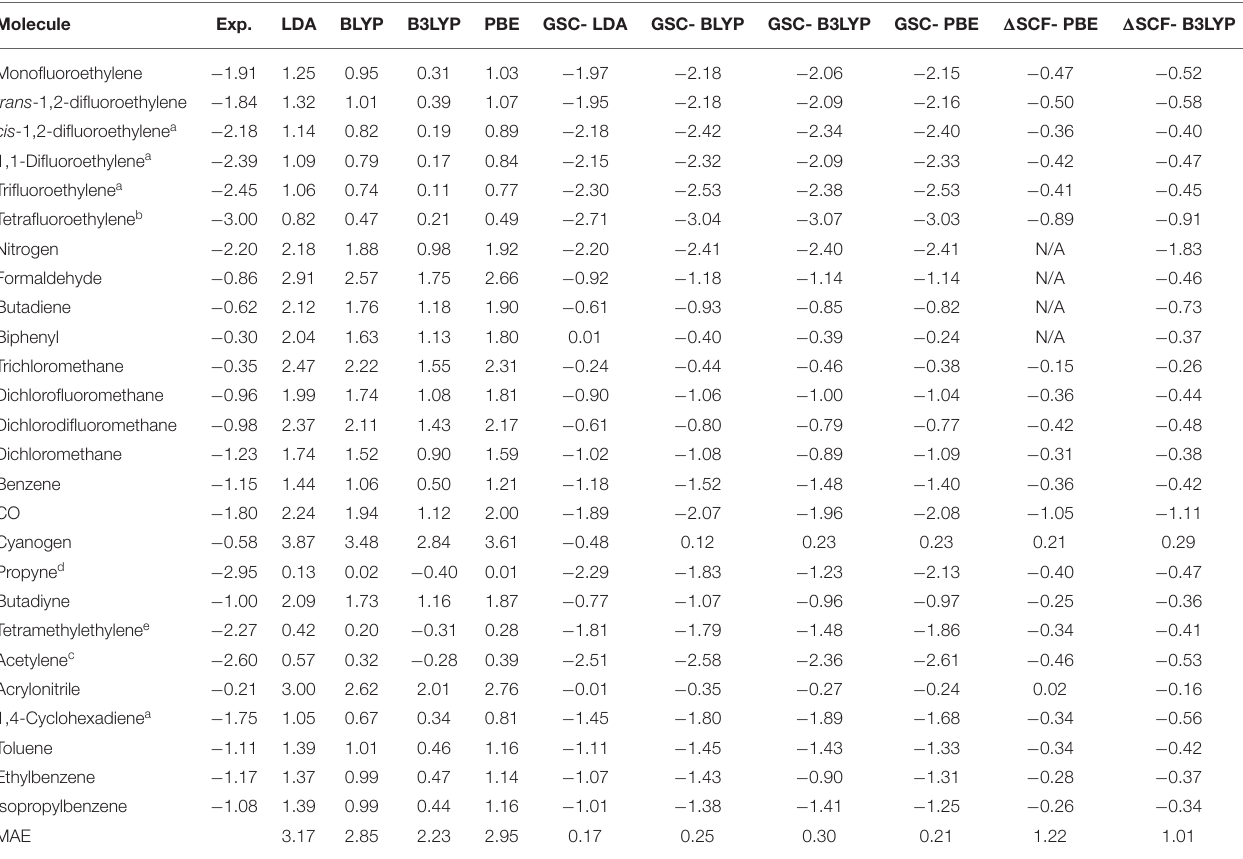
TABLE 2 | Experimental and calculated electron affinities (EAs) of 26 new molecules that are not included in Tozer and De Proft (2005) and Zhang et al. (2018). Molecule